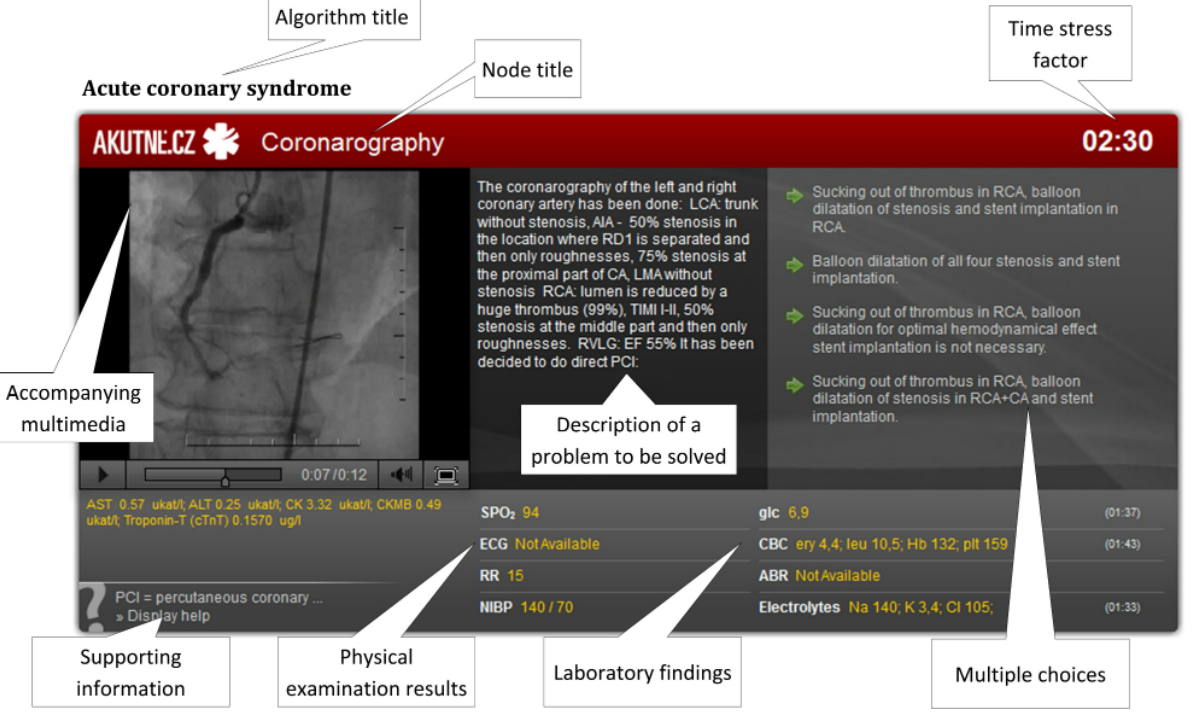
Figure 5. An explained screenshot for 1 node of an algorithm for training clinical reasoning skills in acute coronary